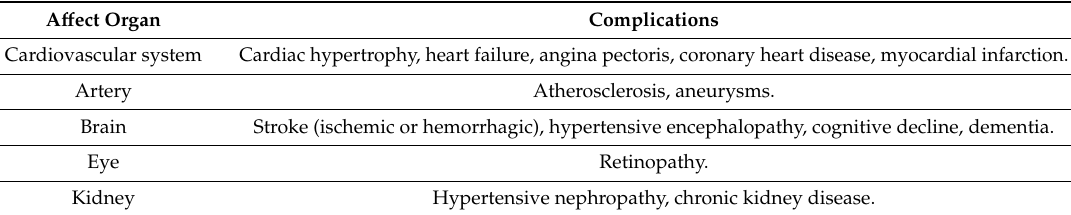
Table 1. Complications of